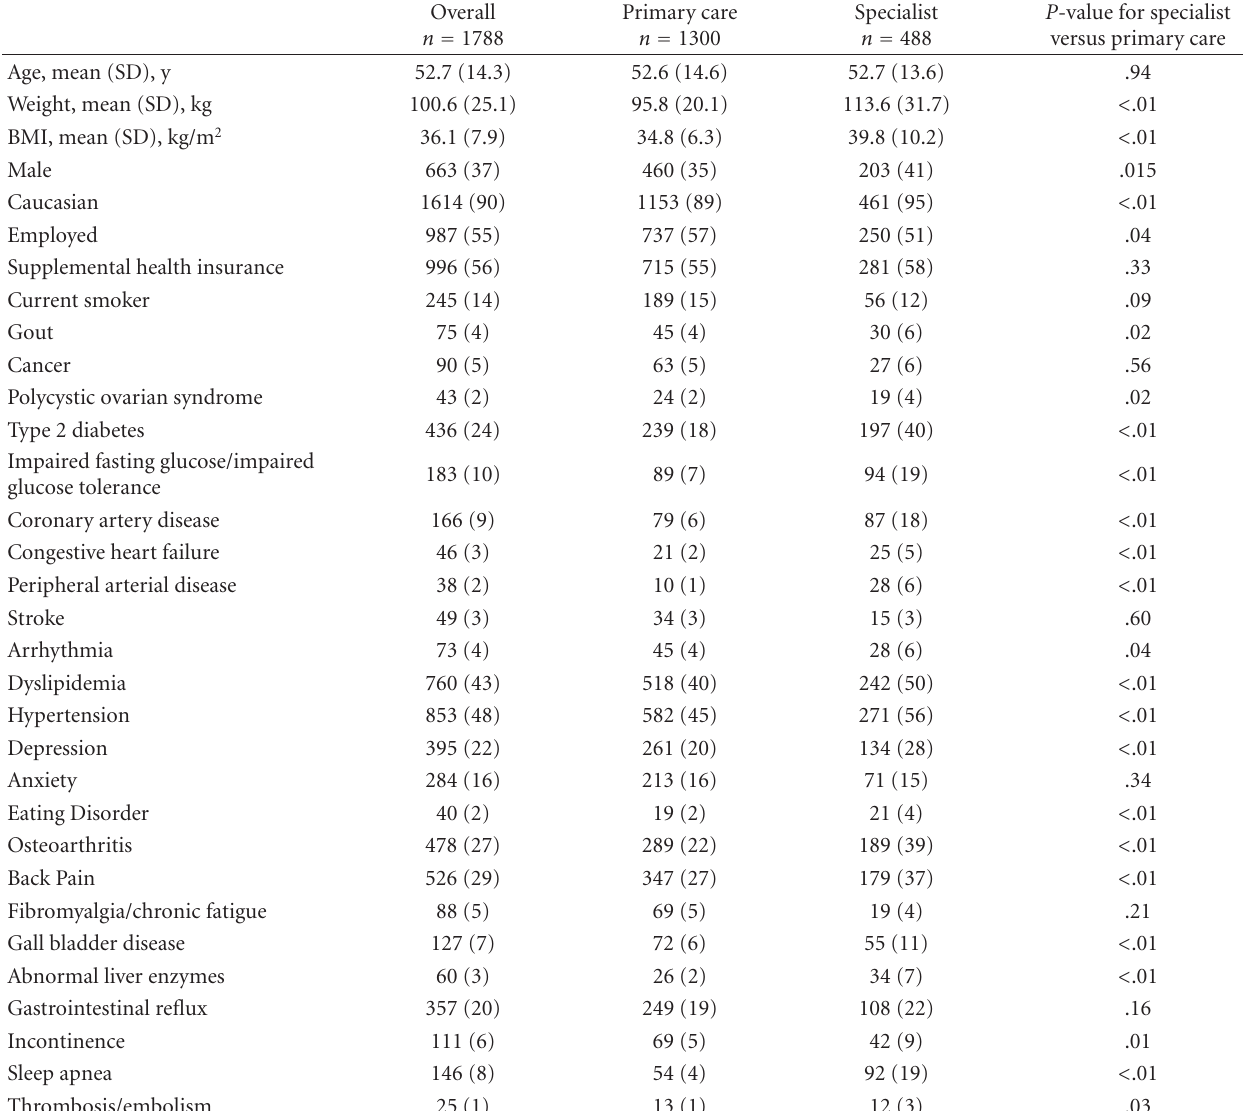
Table 1: Baseline